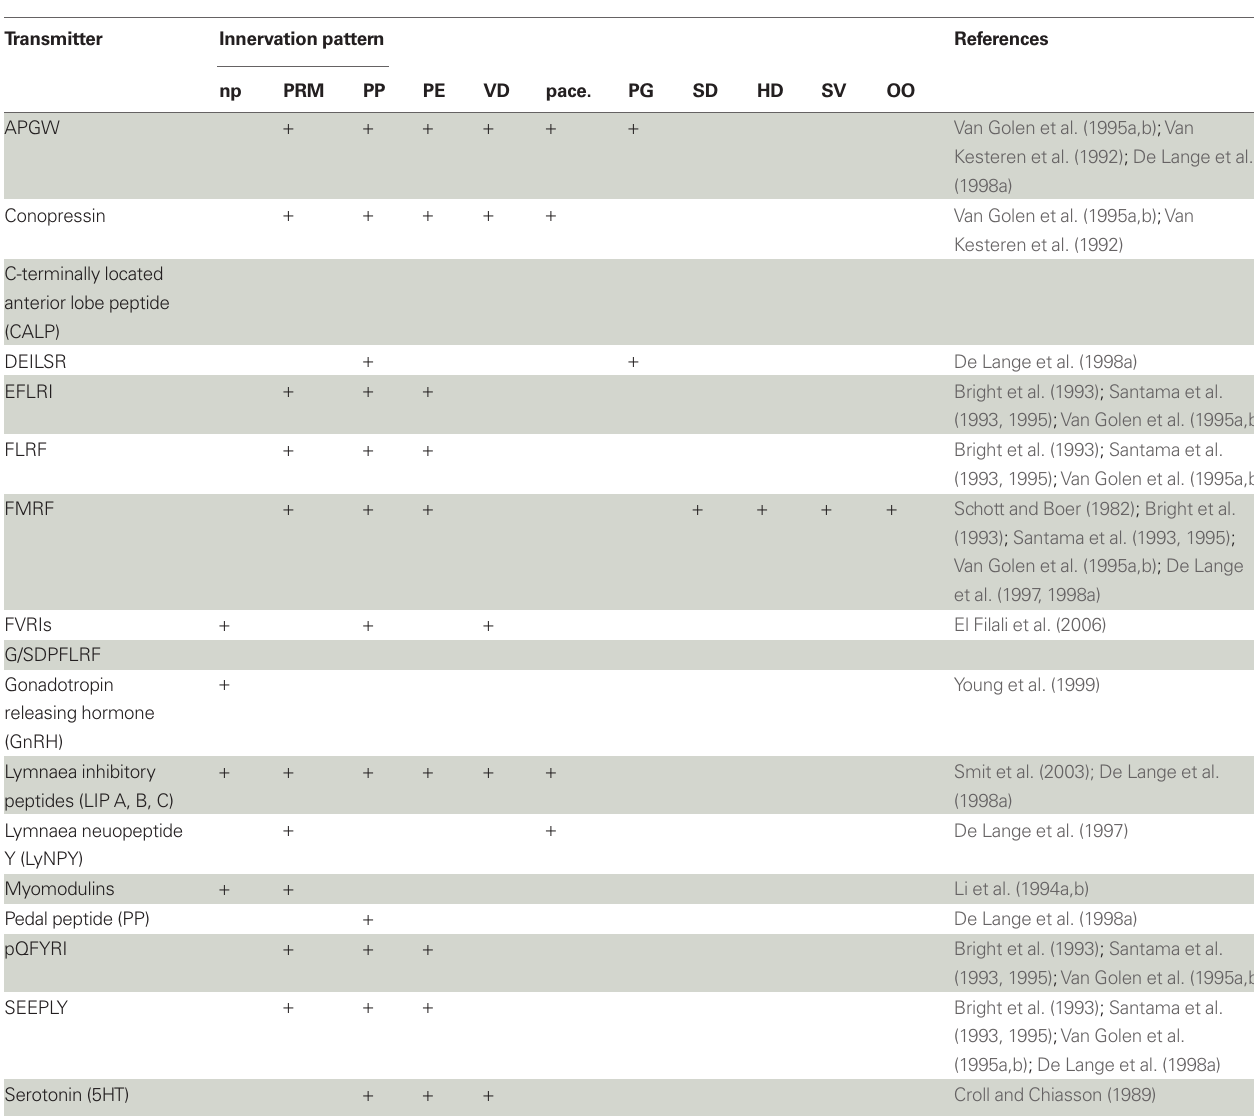
Table 2 | Pattern of innervation by fibers containing the different transmitters involved in male reproduction of hermaphroditic freshwater snails.